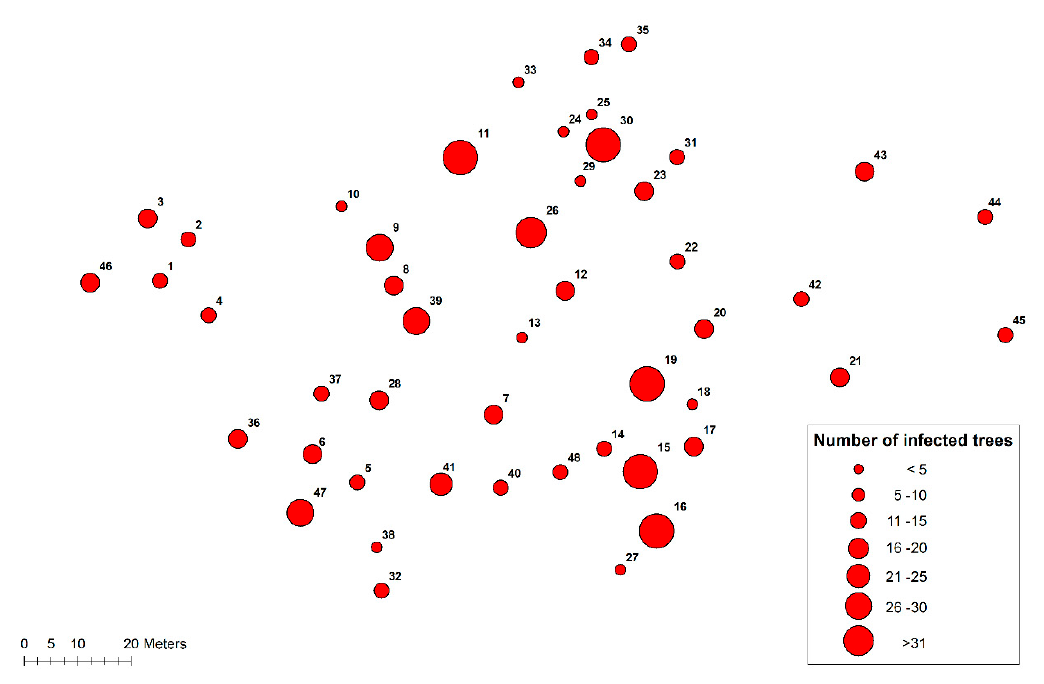
Figure 3. Location of 48 disease centers on the 1.2 ha regeneration area. The size of the circle indicates the number of infected trees in the disease center.